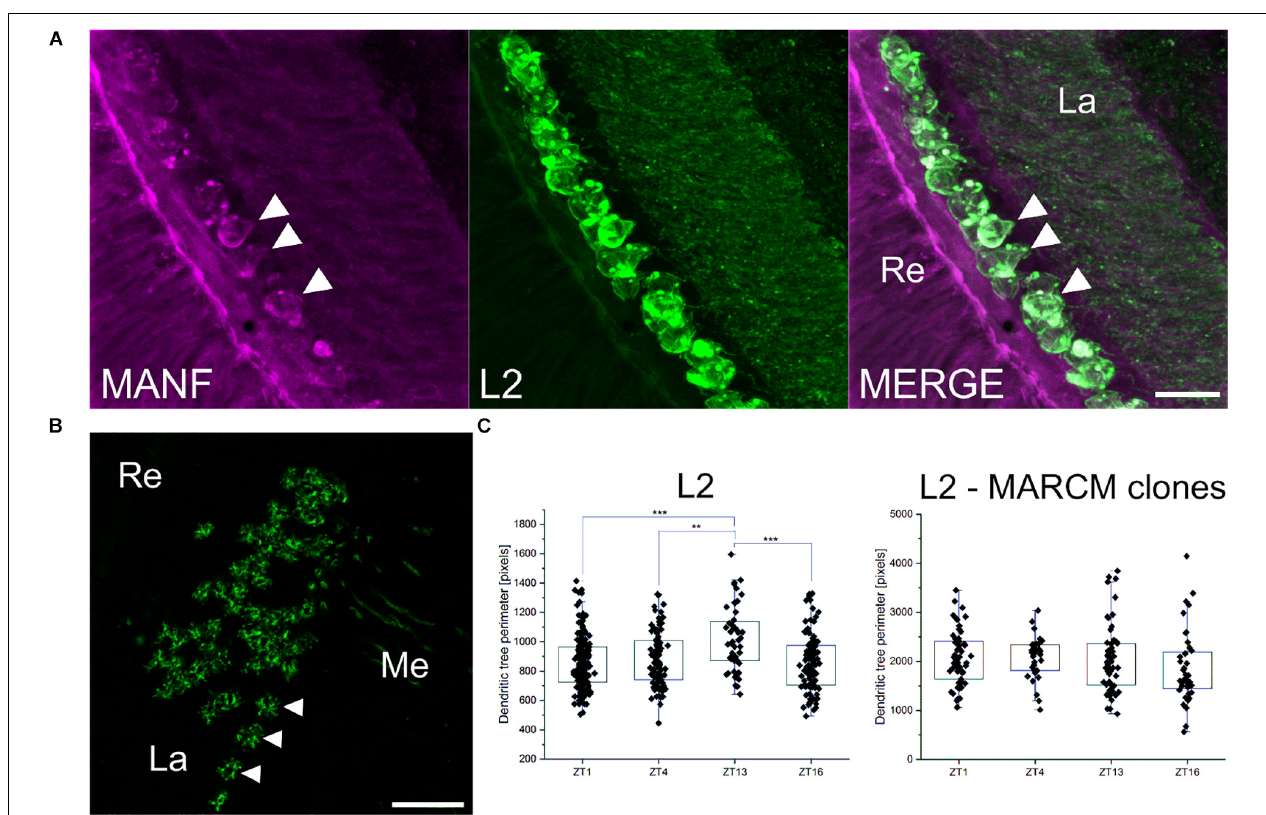
FIGURE 7 | The role of DmMANF in L2 interneurons in the visual system. (A) Expression of DmMANF (magenta) in cell bodies of GFP-labelled L2 interneurons (green) in the lamina. Arrowheads indicate DmMANF-expressing L2 cells (B) Cross section of the lamina showing MARCM clones (L2 and their dendritic trees marked by GFP) mutant for DmMANF . Arrowheads indicate L2 neurons (C) The pattern of the daily rhythm of the L2 dendritic trees of 21D-GAL4 > UAS-mCD8::GFP ( N = 20–25) and MARCM clones mutant for DmMANF ( N = 15–20). In the control group, the dendritic trees were largest at the beginning of the night. The rhythm was abolished in cells lacking DmMANF. Multiple comparison test, ***— p ≤ 0.001, **— p ≤ 0.01. Re: retina, La: lamina, Me: medulla. N represents the number of individuals for each analysis. Scale bars: 10 µ m (A) and 20 µ m (B) . Graphs represent median ± interquartile (the whiskers are determined by the 5th and 95th